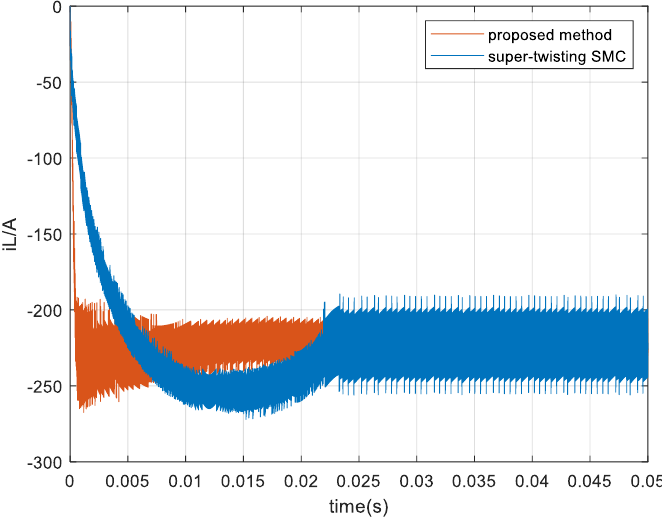
Figure 13. Comparison of inductance current simulation results of the two SMC methods.